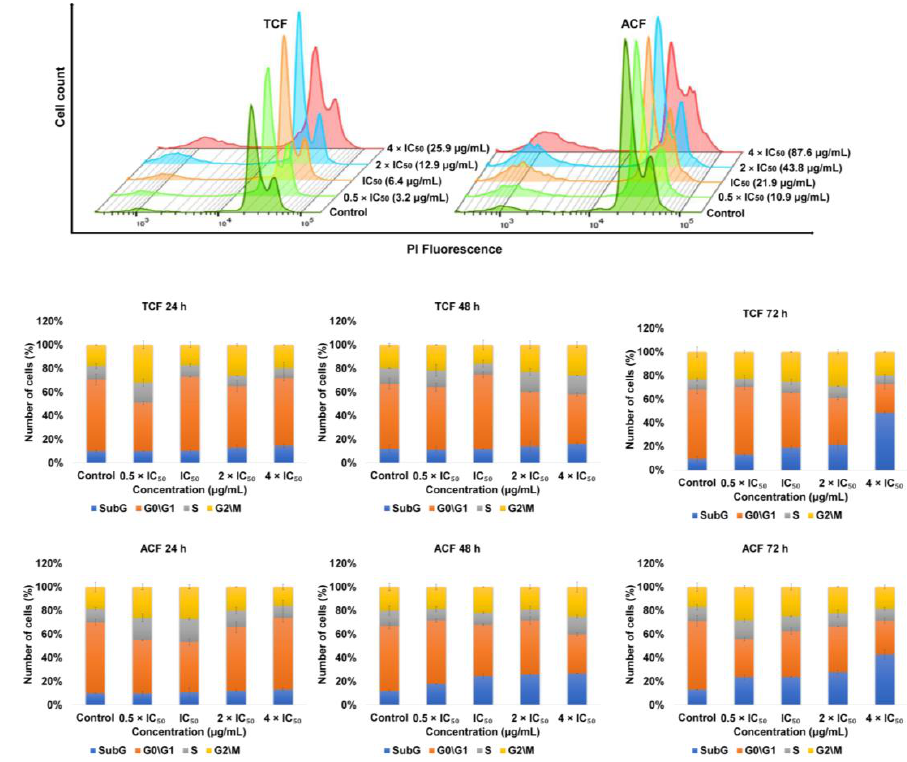
Figure 5. Induction of cell cycle disturbance in NCI-H929 cell lines treated with 0.5, 1, 2, 4 × IC 50 of chloroform fractions of T. vulgaris (TCF) and A. lappa (ACF) following 24, 48, and 72 h, stained with propidium iodide (PI) and analyzed by flowcytometry. Control: NCI-H929 cell without treatment. Molecules 2020 , 25 , x FOR PEER REVIEW